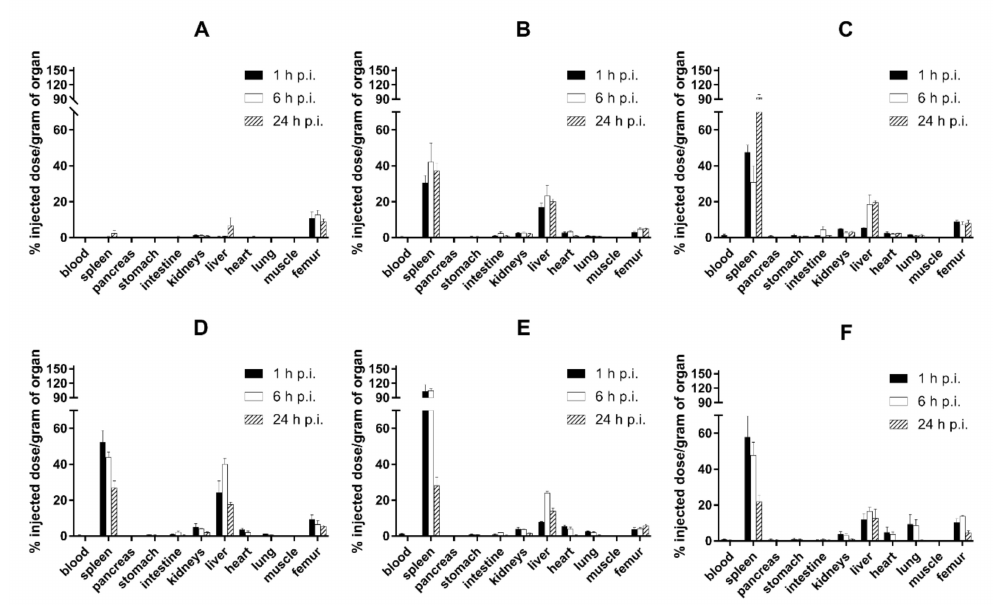
Figure 3. Biodistribution of r.o. injected 99m Tc-HEDP ( A ), 99m Tc-PEG2000-HAP ( B ), 99m Tc-PEG5000-HAP ( C ), 99m Tc-POX5000-HAP ( D ), 99m Tc-POX10000-HAP ( E ) and 99m Tc-PHPMA5000-HAP ( F ) in healthy Balb / c mice 1, 6 and 24h post injection (p.i.) ( n = 3 animals per time